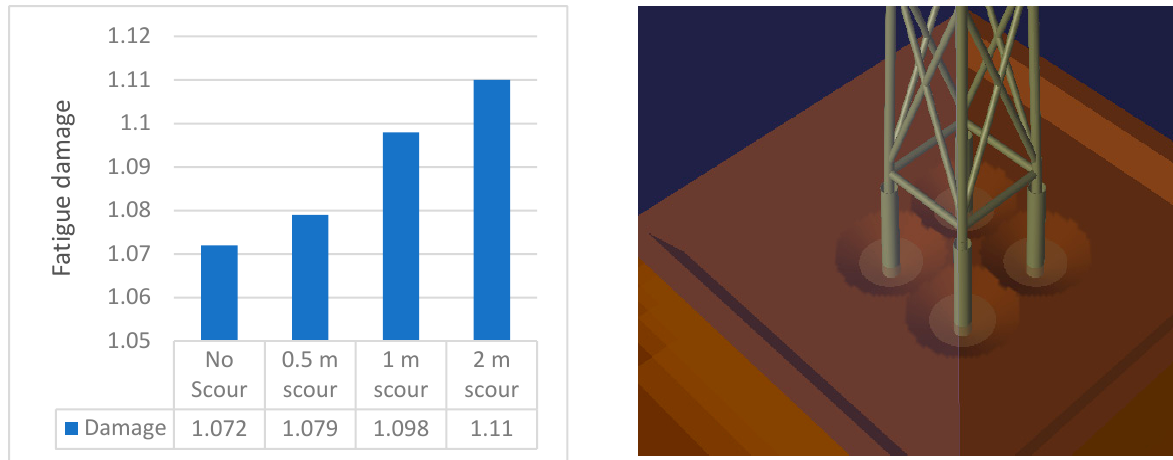
Figure 19. Effect of Scour on fatigue damage.